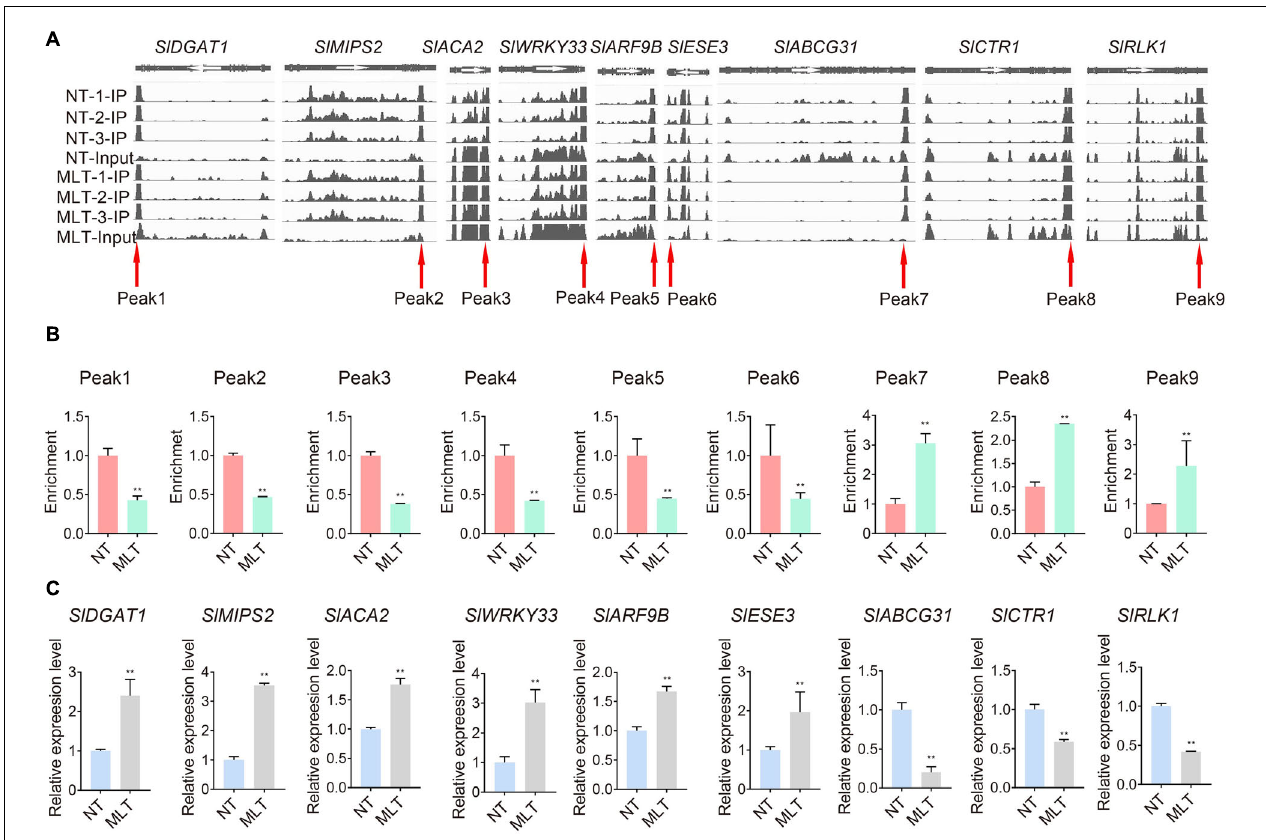
FIGURE 6 | Comparison on m 6 A levels and expression levels of transcripts in NT and MLT anthers at stage-II. (A) Integrative Genome Browser (IGB) showing m 6 A-seq read distributions in transcripts. The red arrowheads indicate the position of m 6 A peaks with significantly changed m 6 A enrichment in MLT-stress stage-II anther compared to NT. The white arrowheads represent the direction of gene. (B) The m 6 A enrichment of transcripts involved in pollen development in NT and MLT anthers. The level of m 6 A in stage-II under NT condition is set to 1. Each value is the mean ± SD ( n = 3 biological replicates with 15 plants each). * P < 0.05; ** P < 0.01 (two-tailed Student’s t- test). (C) qRT-PCR analysis validates the different m 6 A enrichment peak related genes expression levels between NT and MLT anthers. The levels of genes expression normalized to Ubiquitin expression are shown relative to genes expression under NT condition set to 1, Each value is the mean ± SD ( n = at least three biological replicates with 15 plants each). * P < 0.05; ** P < 0.01 (two-tailed Student’s t-